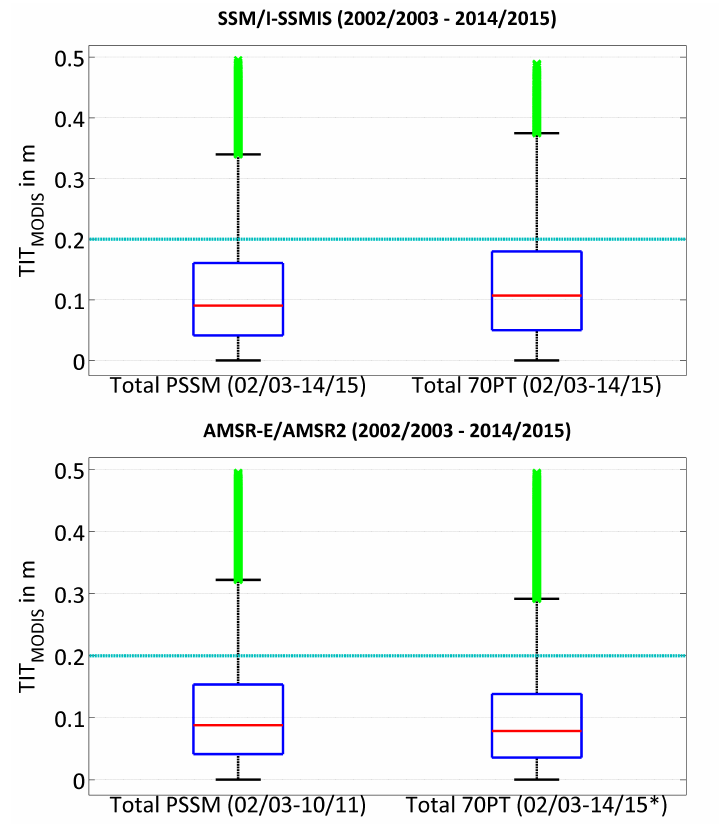
Figure 3. Box-plots of the daily TIT distribution in polynya areas as detected by passive microwave sensors (upper panel: SSM/I-SSMIS; lower panel: AMSR-E/AMSR2). Boxes on the left side show the MODIS TIT distribution in the PSSM polynya area, while the right-hand boxes show the equivalent information for the 70PT method. The light blue horizontal bar marks the 0.2-m TIT-threshold for the MODIS POLA-retrieval. Red bars indicate the median within the 25th and 75th percentile (inter-quartile range; blue boxes). The whisker length has a default value of 1.5-times the inter-quartile range, and outliers are marked in green (* no AMSR-E/AMSR2 sea ice concentrations available for November to March